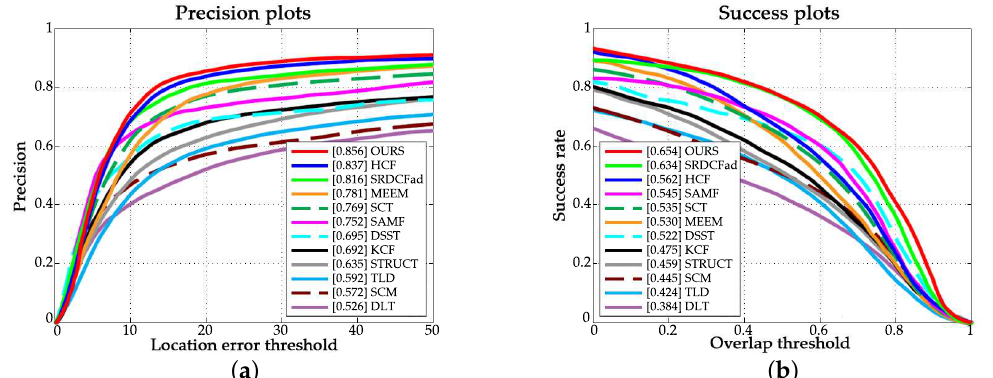
Figure 4. Precision and success plots over the OTB-2015 dataset. ( a ) Precision plot; ( b ) Success